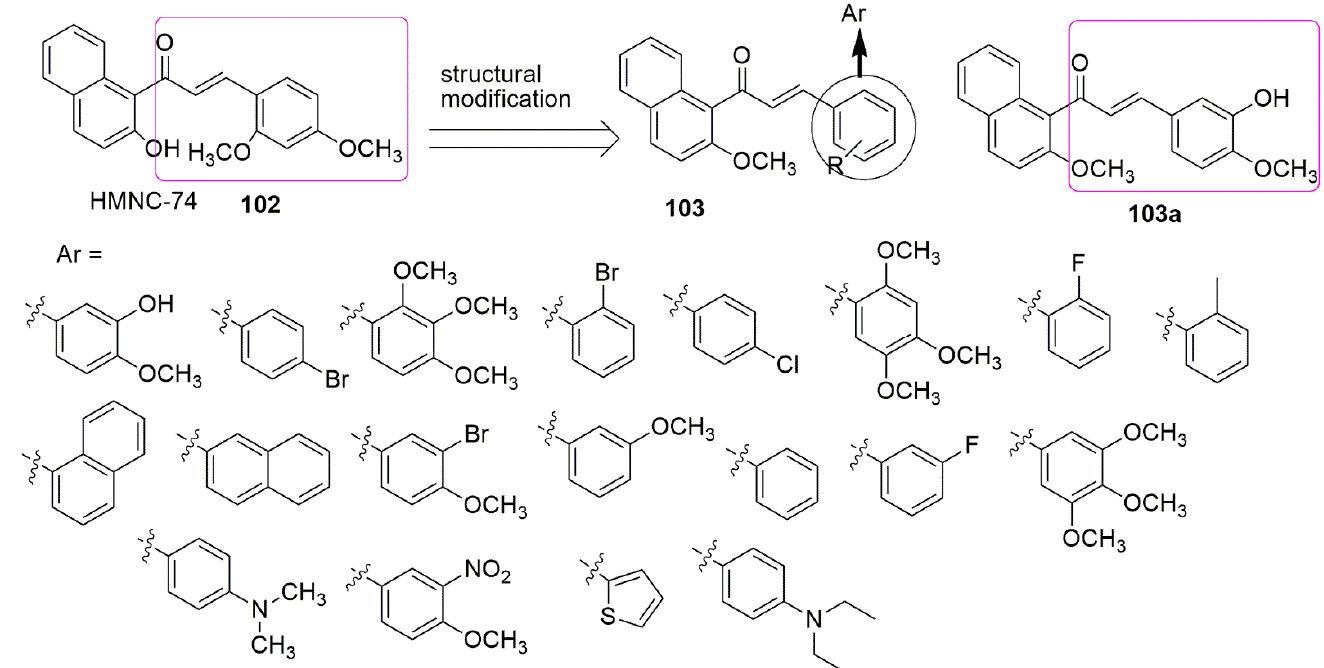
Figure 30. Chemical structures of naphthalene-chalcone hybrids.